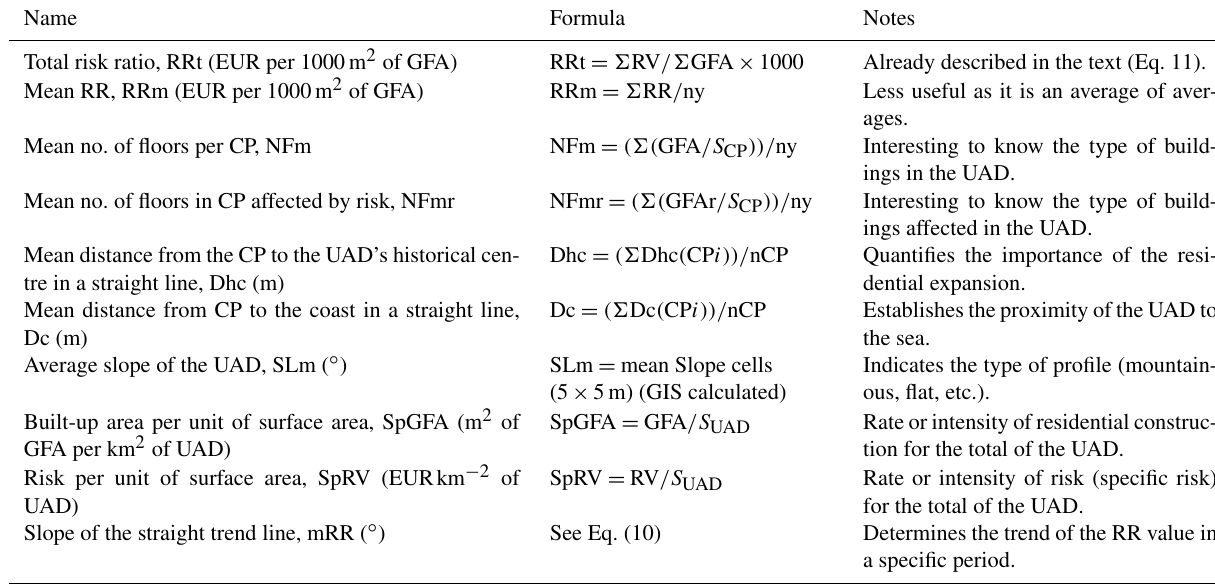
Table 2. Global indicators per